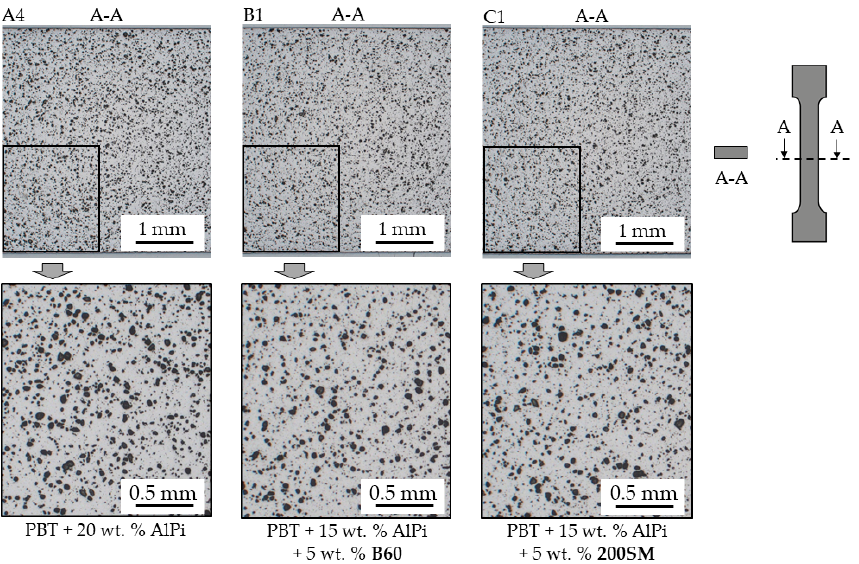
Figure 2. Selection of light microscopy images of the tension rod cross section (A-A) taken in central tension area. Homogeneous particle distribution and no visible agglomerations.